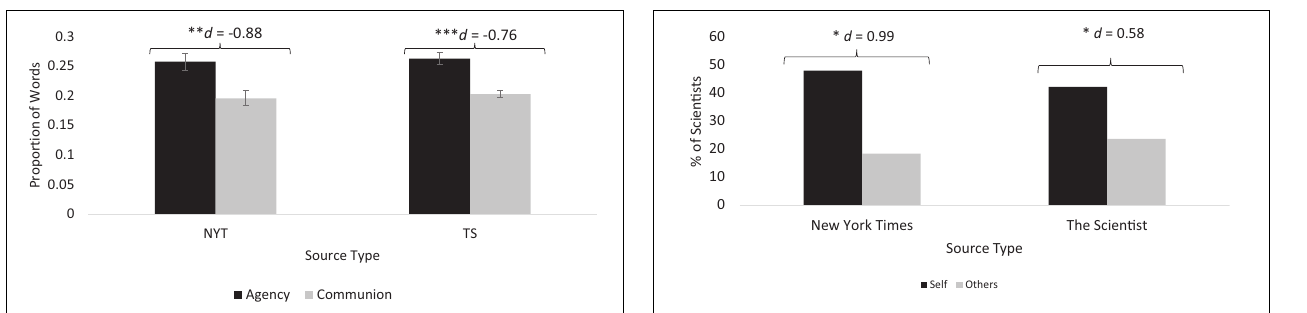
TS: 83.5%) rather than already achieved (NYT: 44.4%; TS: 16.5%);